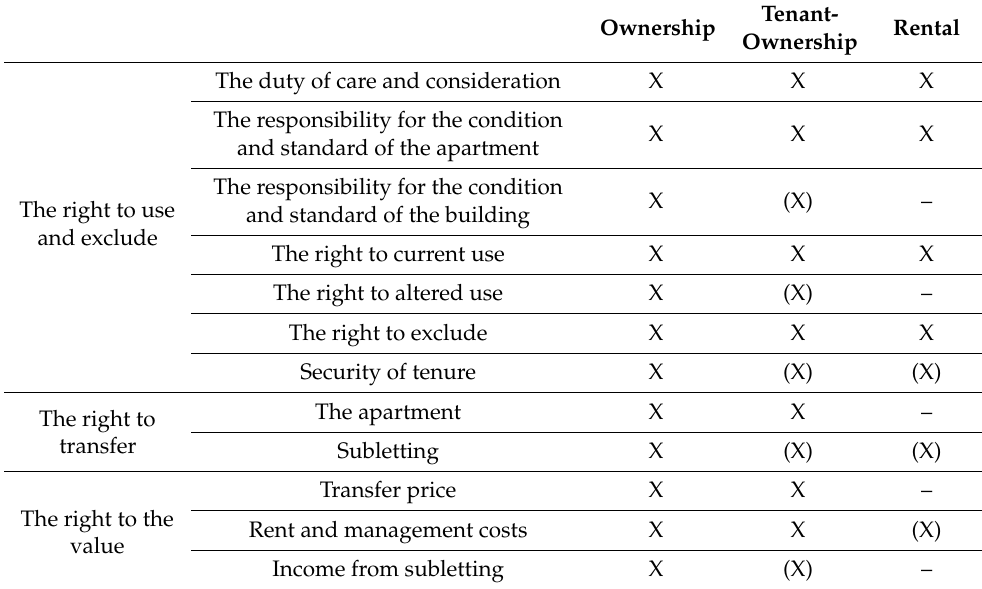
Table 1. Property rights characteristics of the three tenure